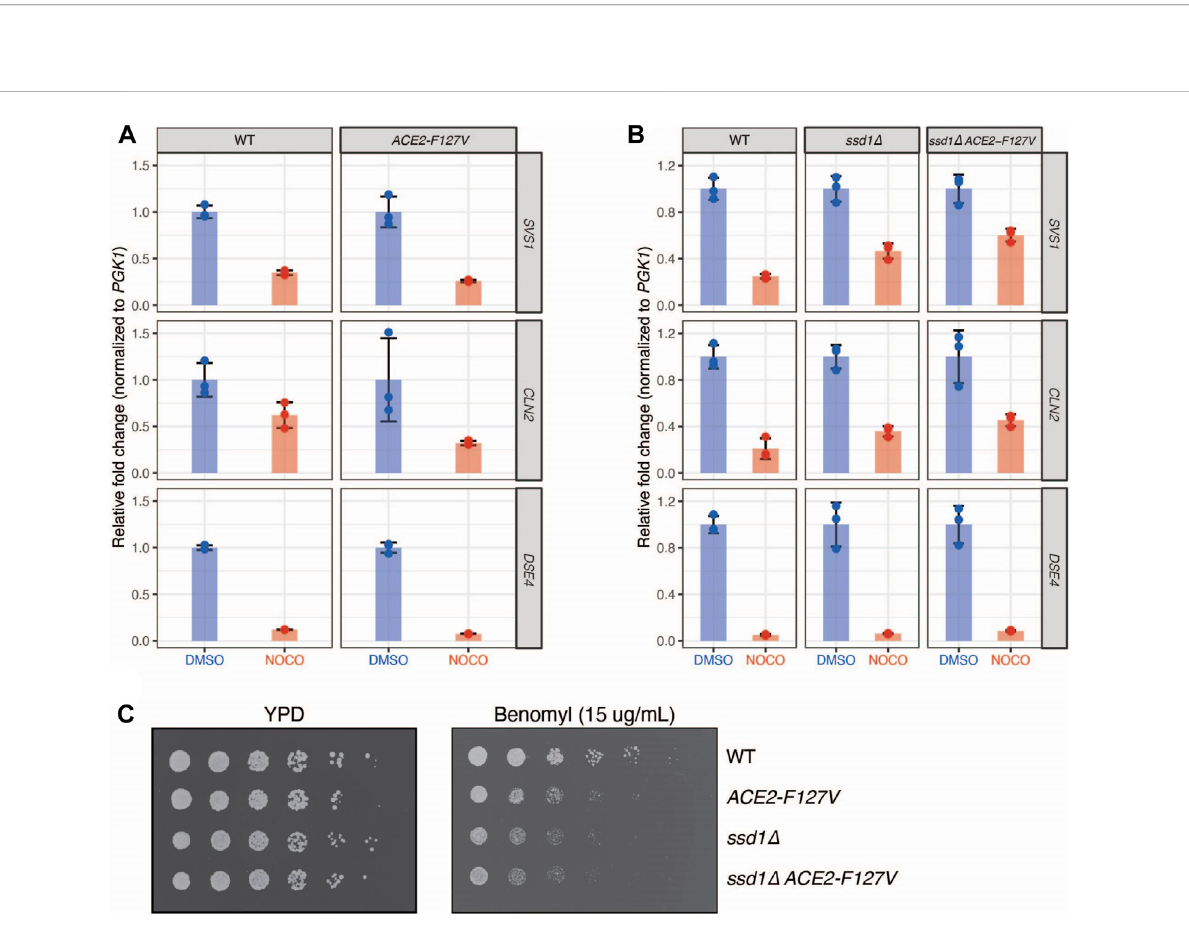
FIGURE 4 Nocodazole induced regulation of gene expression is mediated by Cbk1 signaling pathway. (A) A dominant allele of ACE2 is not suf fi cient to rescue nocodazole induced changes in gene expression. WT (SBY21046) and ACE2-F127V (SBY21047) cells were treated with DMSO (Blue) or nocodazole (10 μ g/ml; Red). N = 3 independent replicates for each treatment. qRT-PCR quanti fi cation of individual gene expression values ( SVS1, CLN2, DSE4 ) were normalized to PGK1 expression values within the same sample and fold change is relative to genotype-matched DMSO controls. Error bars represent standard deviation. Expression levels are not elevated in ACE2-F127V strains compared to WT upon nocodazole treatment( p =0.99,0.97,0.99for SVS1,CLN2, and DSE4 respectively;two-sample t -test). (B) Deletionof SSD1 partiallyrescuesnocodazole-induced changes in gene expression. WT (SBY21118), ssd1 Δ (SBY21138), and ssd1 Δ ACE2-F127V (SBY21137) were treated with DMSO (Blue) or nocodazole (10 μ g/ml; Red). N = 3 independent replicates for each treatment. qRT-PCR quanti fi cation of individual gene expression values ( SVS1, CLN2, DSE4 ) were normalized to PGK1 expression values within the same sample and fold change is relative to genotype-matched DMSO controls. Error bars represent standard deviation. Expression levels are elevated in strains compared to WT upon nocodazole treatment ( p < 0.05 for SVS1, CLN2, and DSE4 in both mutant backgrounds; two-sample t -test). (C) Modulation of downstream Cbk1 targets sensitizes cells to the microtubule destabilizing drug benomyl. 5-fold serial dilutions of WT (SBY21118), ACE2-F127V (SBY21119), ssd1 Δ (SBY21138), and ssd1 Δ ACE2-F127V (SBY21137) were plated onto YPD or YPD benomyl (15 μ g/mL) plates and incubated at 23 ° C for 3